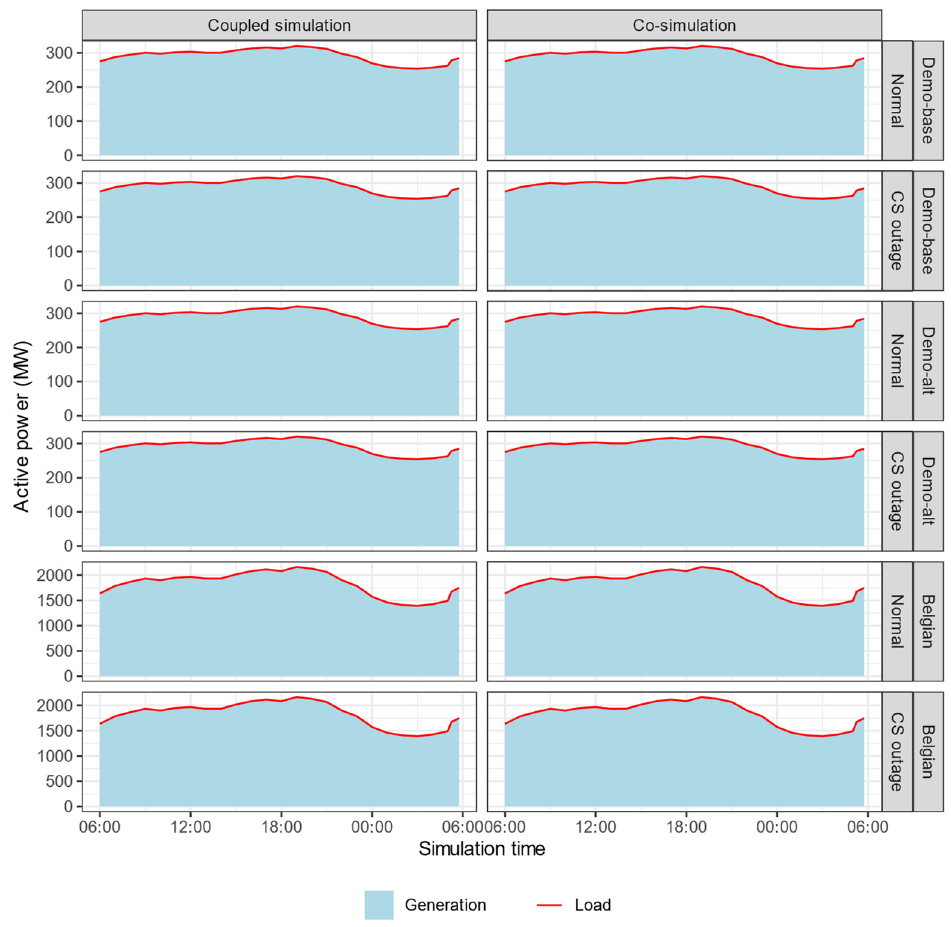
Figure 9. Total load requirement and power generation (MW) for every 15 min timestep across the various combinations of networks and disruption scenarios. Note the difference in y -axis scales between the demo and Belgian cases. Load and power requirements are identical across the two ap- proaches.